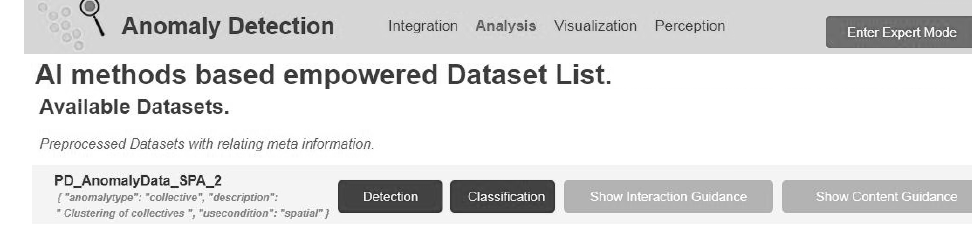
Figure 15. UI implementation for end user data analysis.